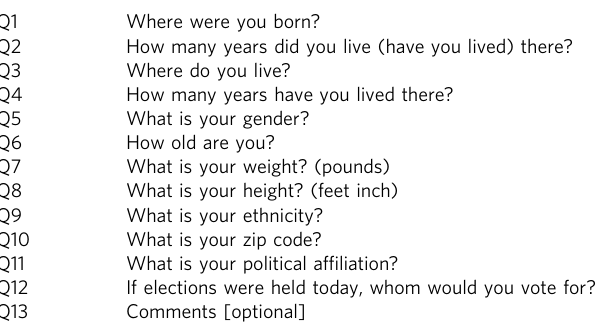
Table 2 Demographic questionnaire for Experiments 1 and